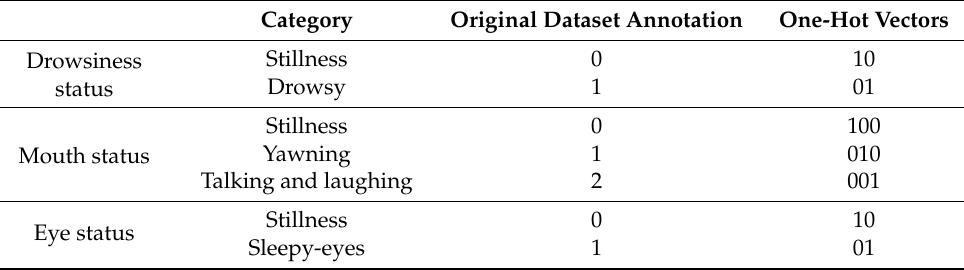
Table 1. A detailed explanation of transforming the NTHU-DDD dataset frame level annotation into one-hot